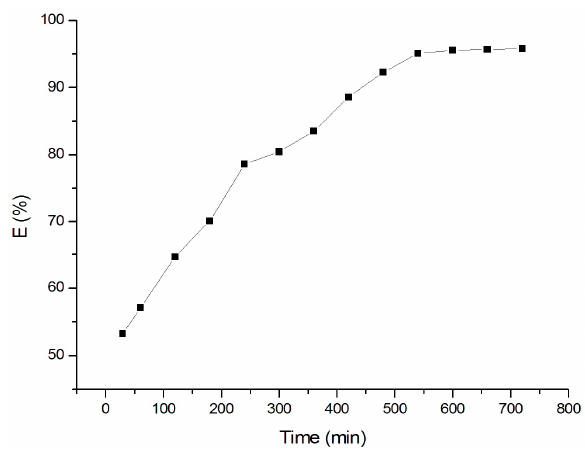
Figure 5. Adsorption of Cr(VI) on goethite with different contact times.